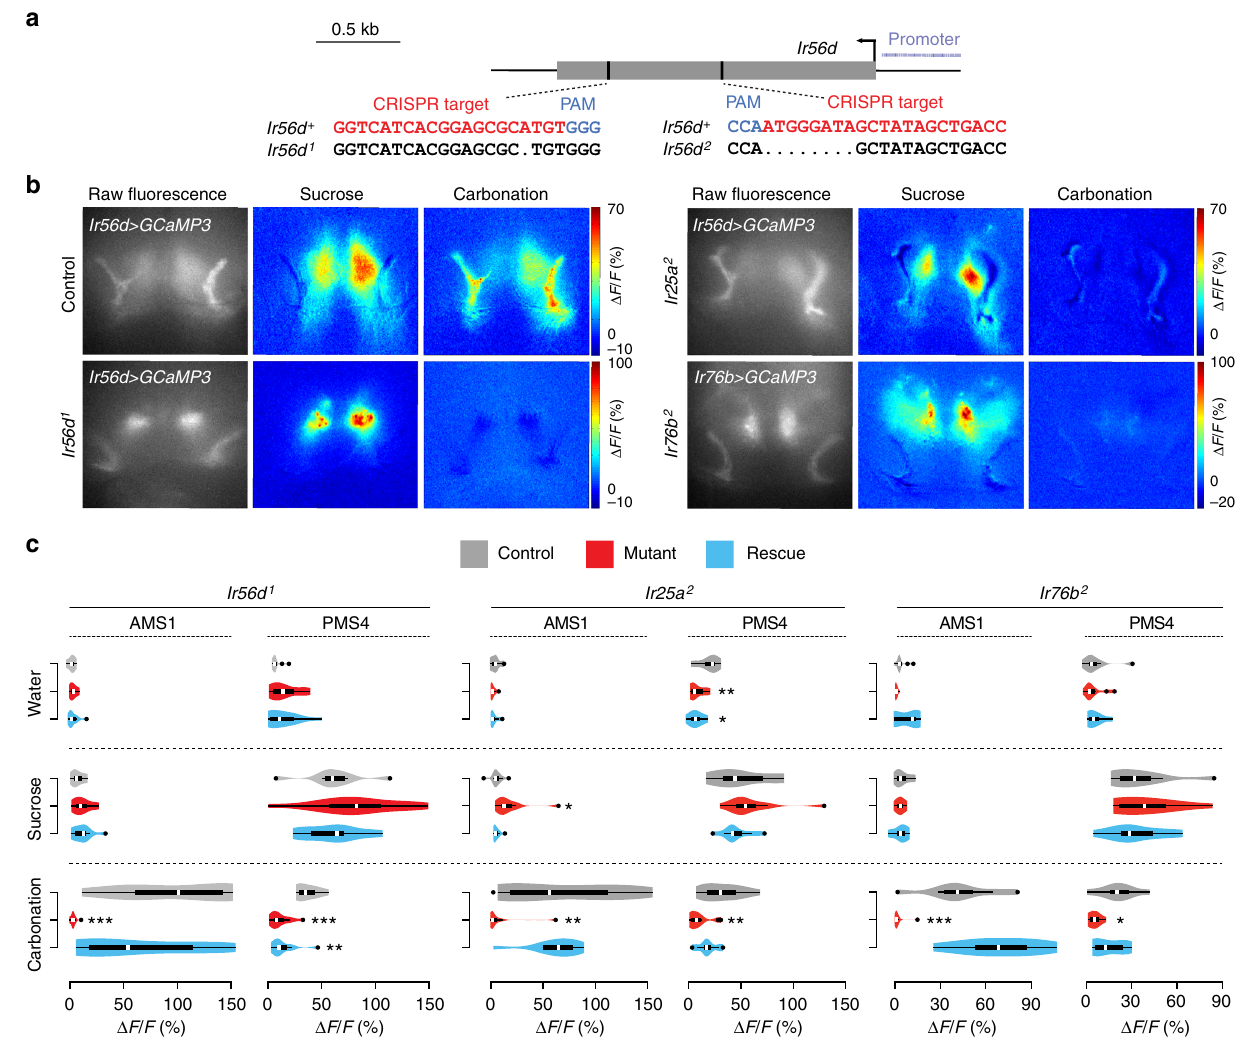
Fig. 6 IR56d, IR25a and IR76b are required for sensory responses to carbonation but not sucrose. a Schematic of the Ir56d locus (single exon in grey), showing the position of the CRISPR target and the sequence of the Ir56d mutant alleles in these regions. PAM protospacer adjacent motif. b Raw fl uorescence of GCaMP3 expressed in IR56d neurons, and colour-coded images (re fl ecting the maximal GCaMP3 fl uorescence intensity changes; scale bars for each genotype on the right) in control, Ir56d 1 , Ir25a 2 and Ir76b 2 mutant fl ies stimulated with 1 M sucrose and a carbonated solution (as in Fig. 5c). For genotypes, see c . c Quanti fi cation of changes in Δ F / F in the ROIs as shown in Fig. 5a, b upon application of the indicated chemicals to the proboscis of the indicated genotypes: IR56d: Control: w;Bl/ + ; UAS-GCaMP3,Ir56d-Gal4/ + ( n = 8); Mutant: w;Ir56d 1 /Ir56d 1 ; UAS-GCaMP3,Ir56d-Gal4/ + ( n = 11);